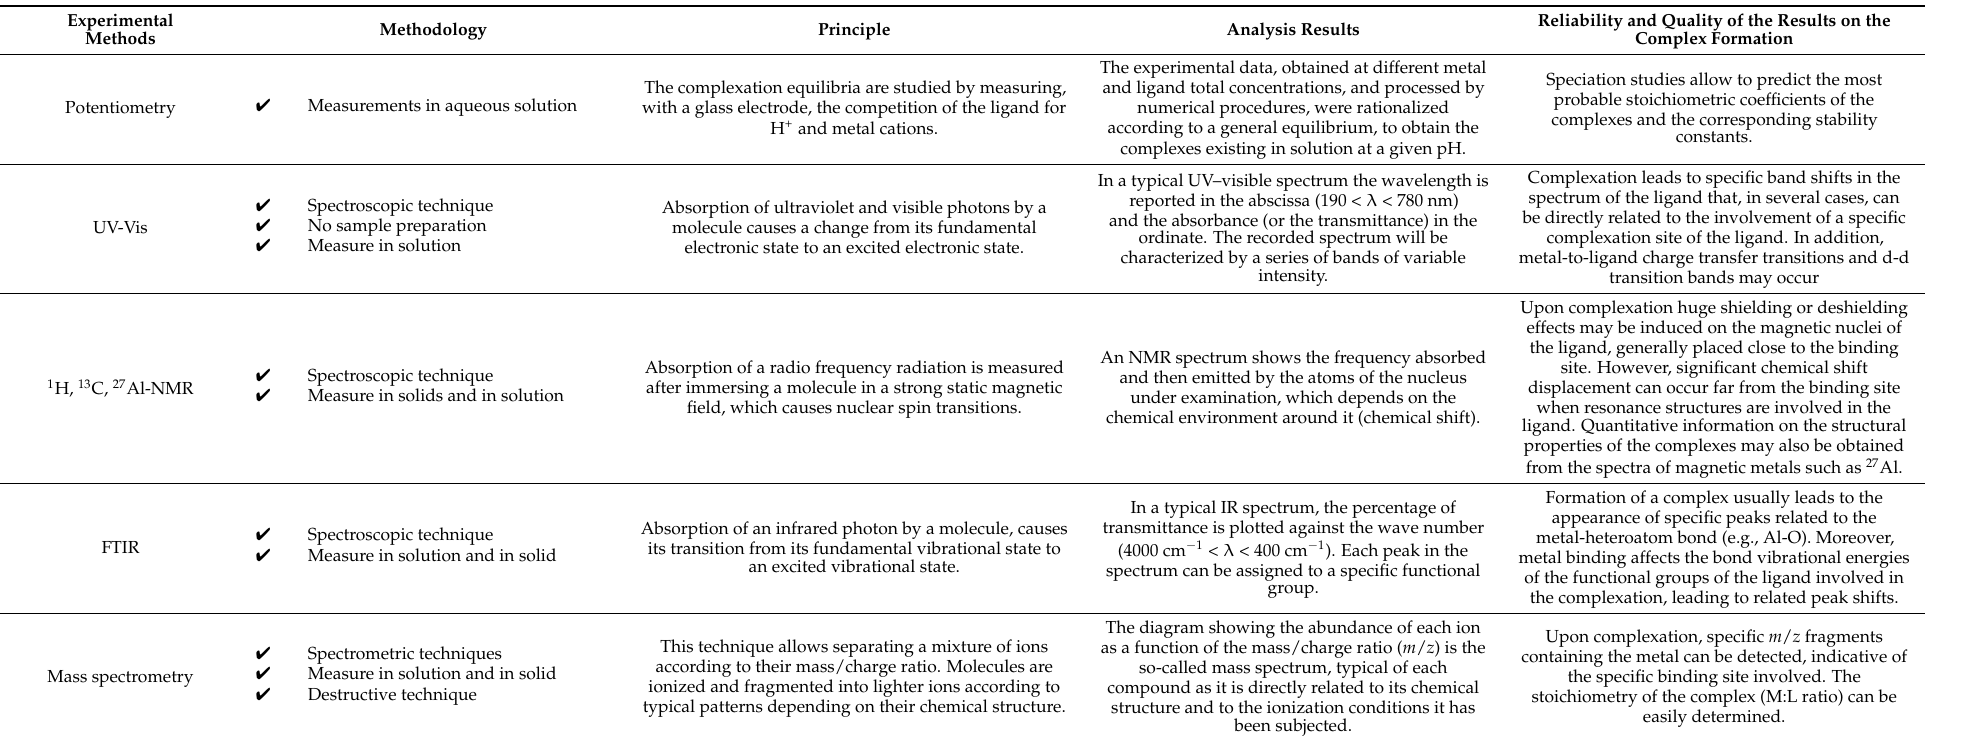
Table 4. Details of the identification and characterization